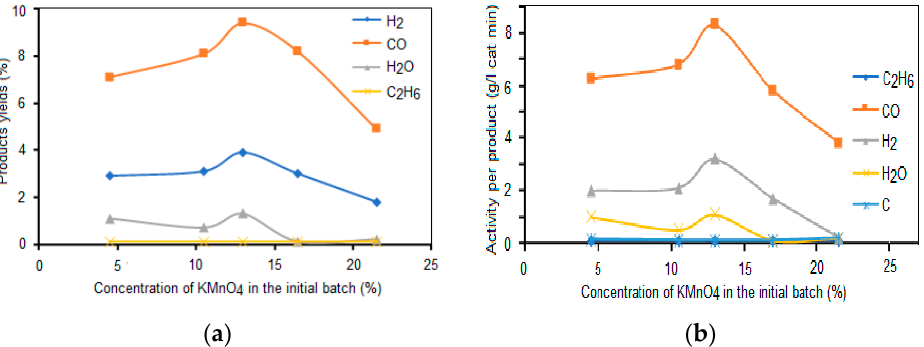
Figure 11. Influence of KMnO 4 concentration in the initial batch on the products yields ( a ) and catalytic activity per product ( b ).